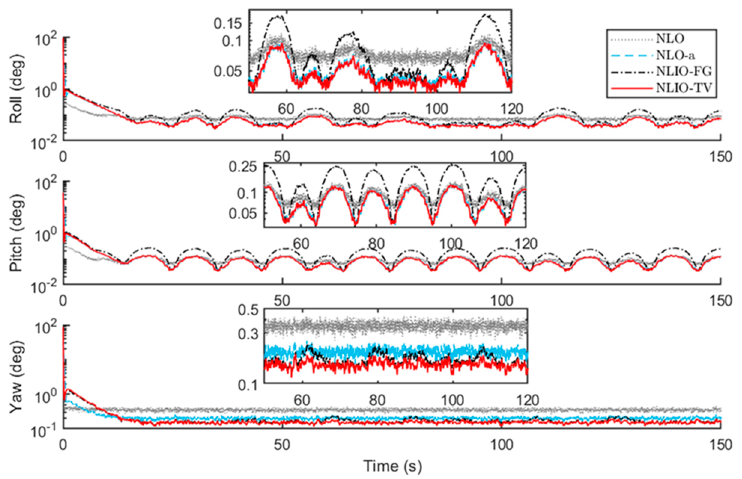
Figure 3. Averaged absolute vector measurement estimation errors over 100 simulations for Case 1. ( a ) Accelerometer measurement estimation errors evaluated by the auxiliary observers of the nonlinear observer (NLO) and nonlinear interconnected observer (NLIO). ( b ) Magnetometer measurement estimation errors evaluated by the auxiliary observers of the NLO and NLIOs. Since the NLO does not estimate the vector measurements, its vector measurement errors are identical to the difference between the sensor measurements and the truth values. The measurement errors’